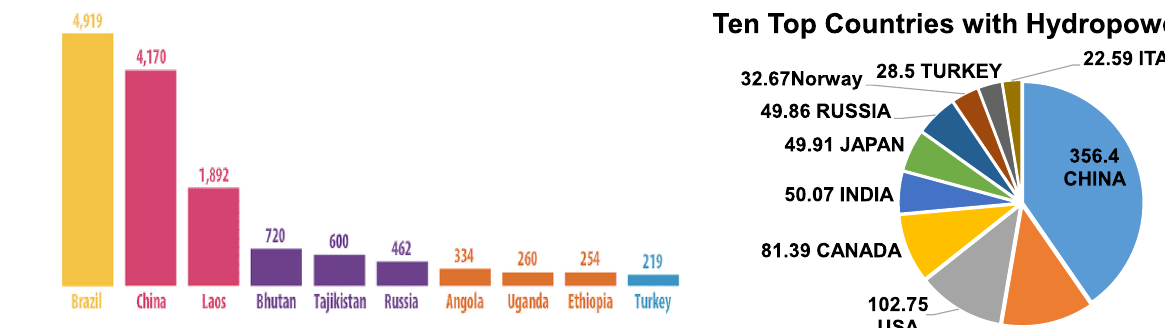
Fig. 8. Top ten countries added new Hydropower installations, (TWH), to their records, [12]. This is a rise of 1.2% per year. Fig. 9. The top 10 countries with hydropower in the world [14].